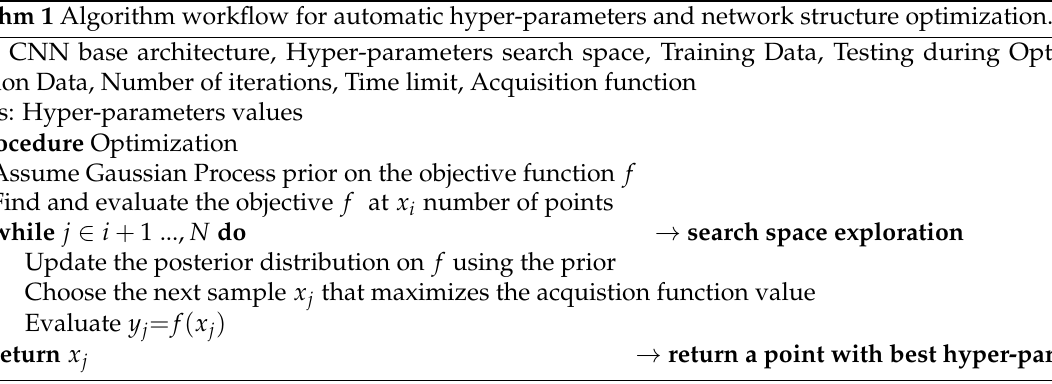
Algorithm 1 Algorithm workflow for automatic hyper-parameters and network structure